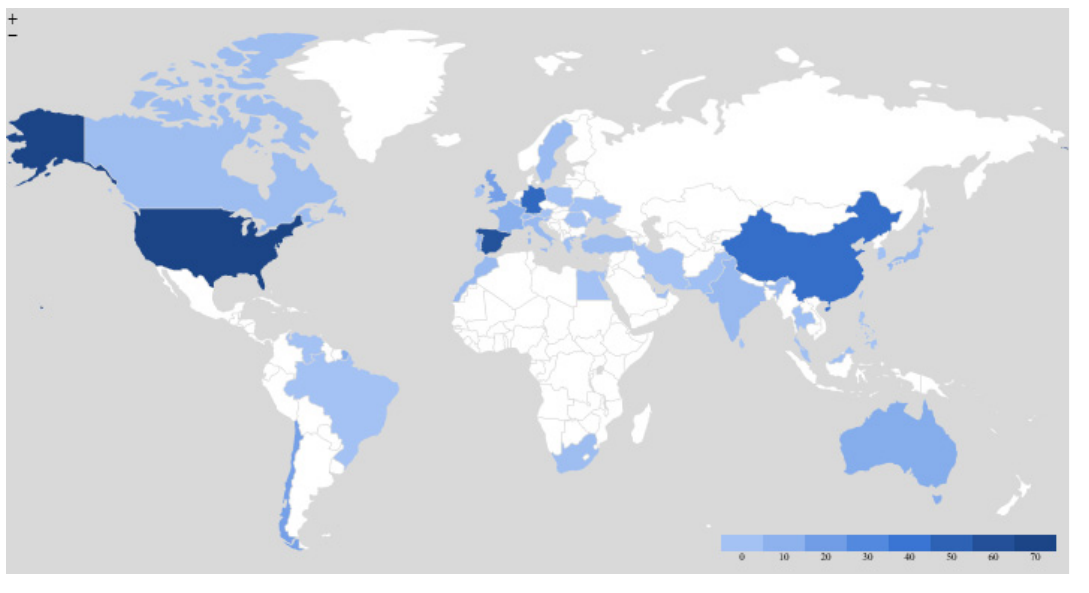
Figure 5. Heat map of countries.